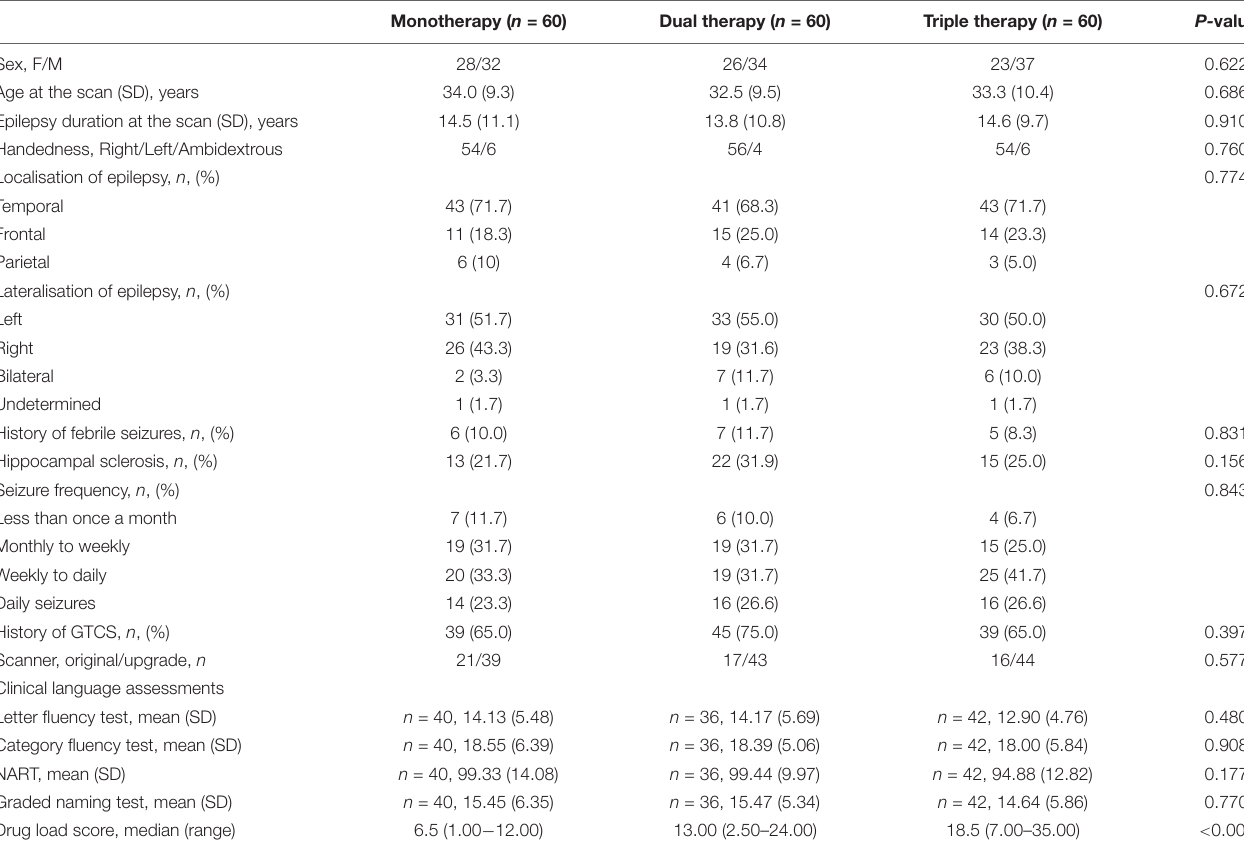
TABLE 3 | Demographic and clinical features of people taking ASMs with moderate cognitive effects in mono/dual/triple